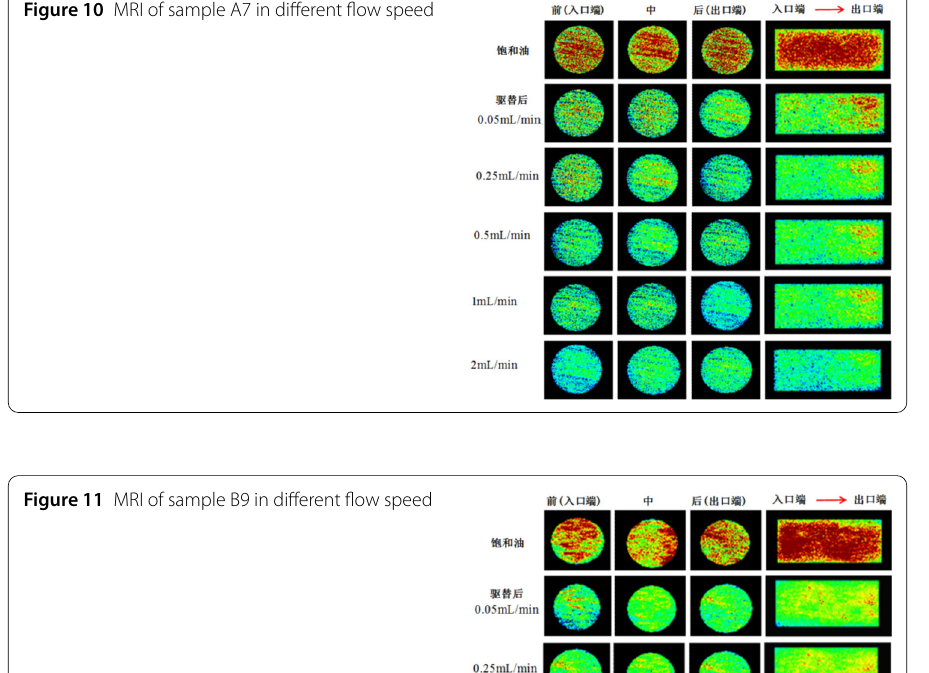
Figure 10 MRI of sample A7 in different flow speed